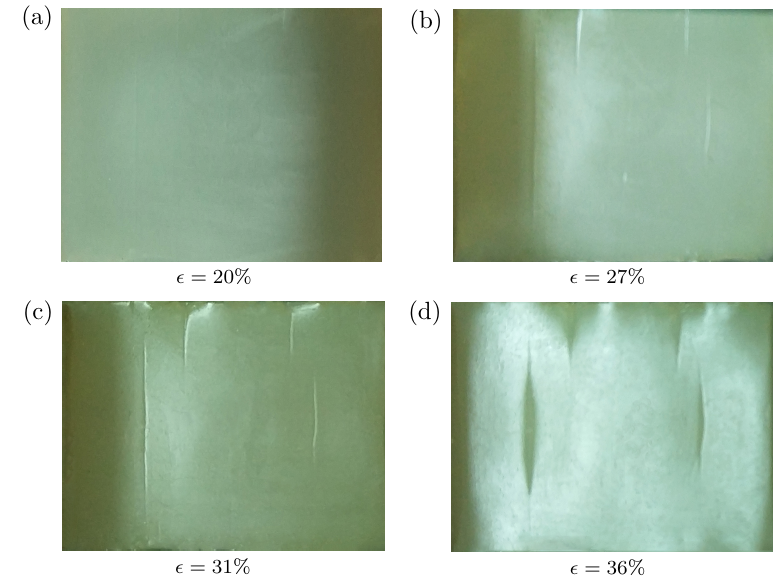
Figure 5. Surface morphology of a cuboid silicone rubber (Ecoflex 00-20 from Smooth-on Inc., Pennsylvania, PA, USA) under different levels of compressive strains: ( a ) 20%; ( b ) 27%; ( c ) 31%; ( d ) 36%. The specimen experiences cyclic pinching before the uniaxial compression.